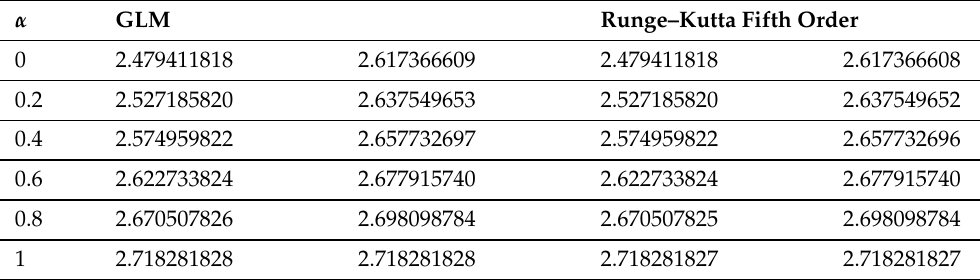
Table 12. Comparison between the GLM and the Runge–Kutta fifth order for the 2-solution at t = 1.